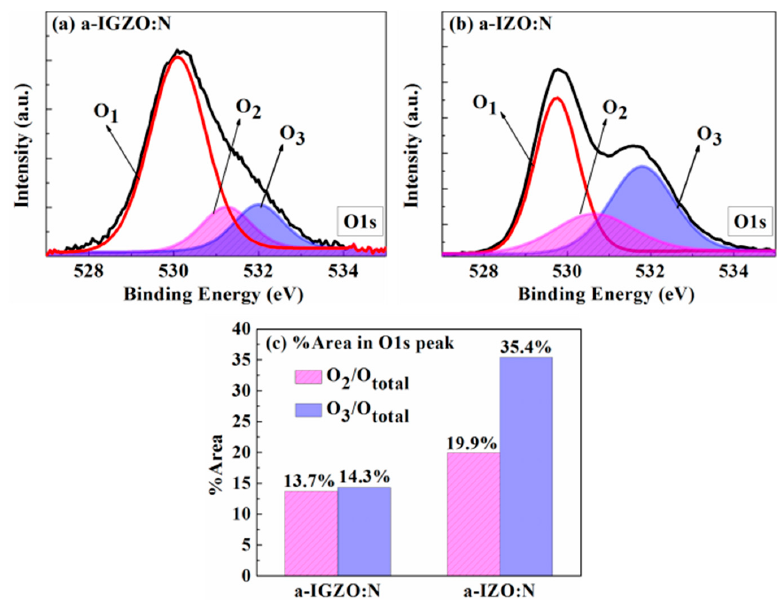
Figure 2. The X-ray photoemission spectroscopy (XPS) measurement and analysis results: ( a ) O1s spectra of the a-IGZO:N film; ( b ) O1s spectra of the a-IZO:N film; and ( c ) %Area of each component in O1s detected by XPS.